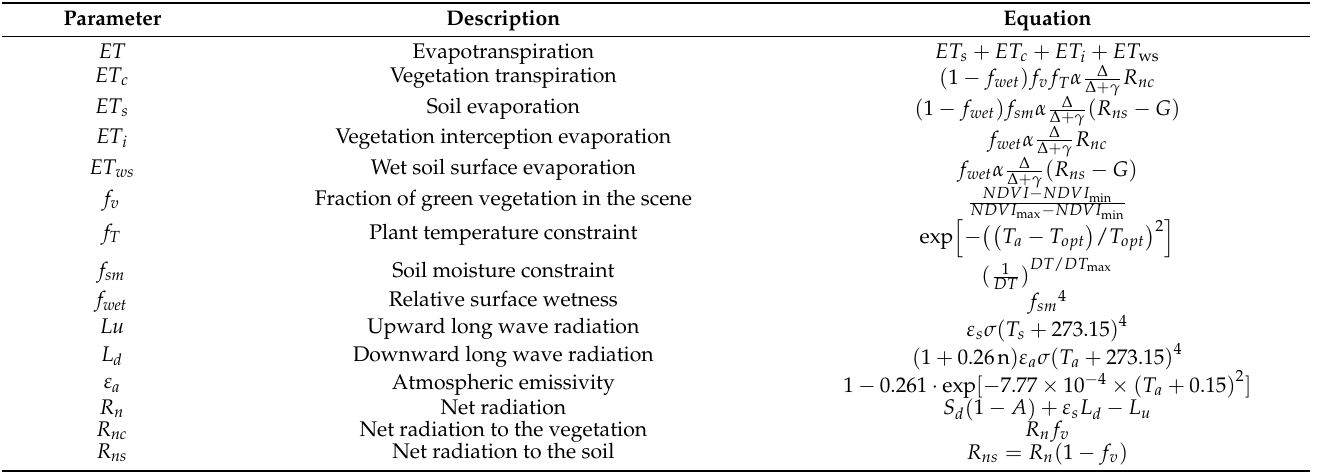
Table A1. Model parameters and